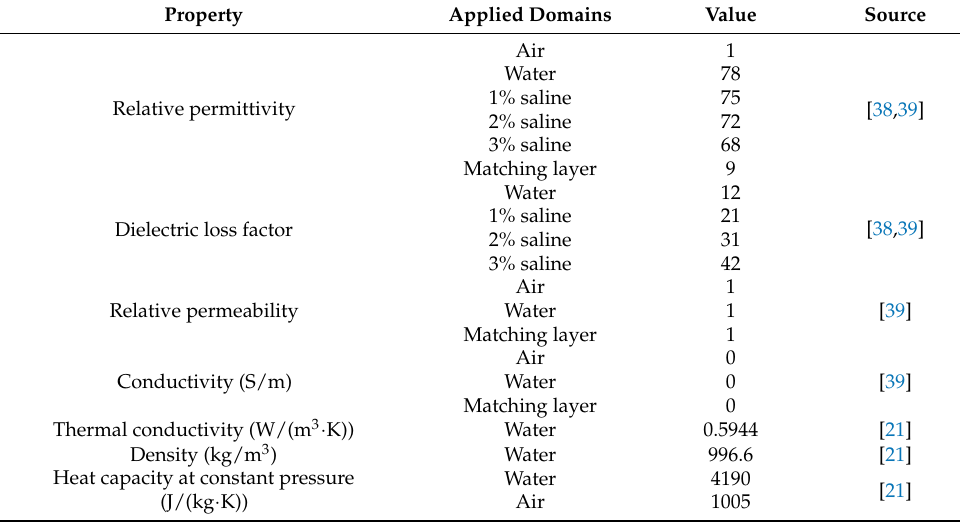
Table 1. Summary of material properties applied in the model.